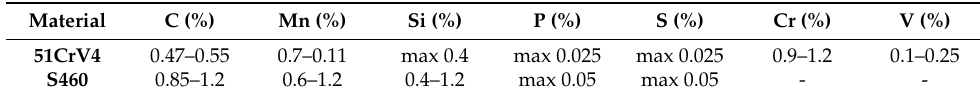
Table 4. Material composition of specimen and